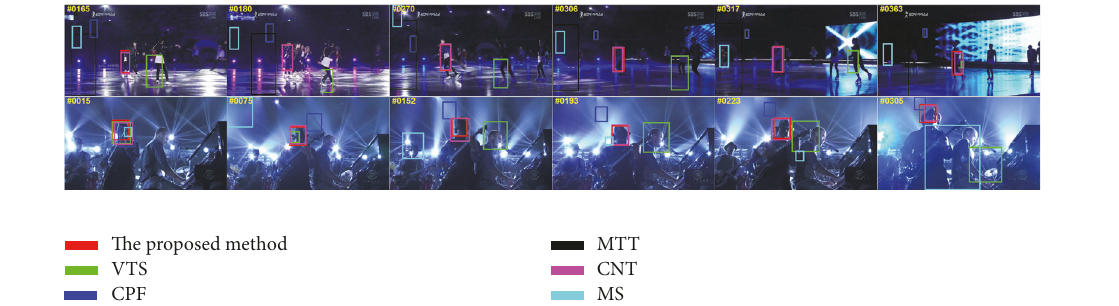
Figure 5: Qualitative evaluation of the tracker on sequences shaking 1 and skating